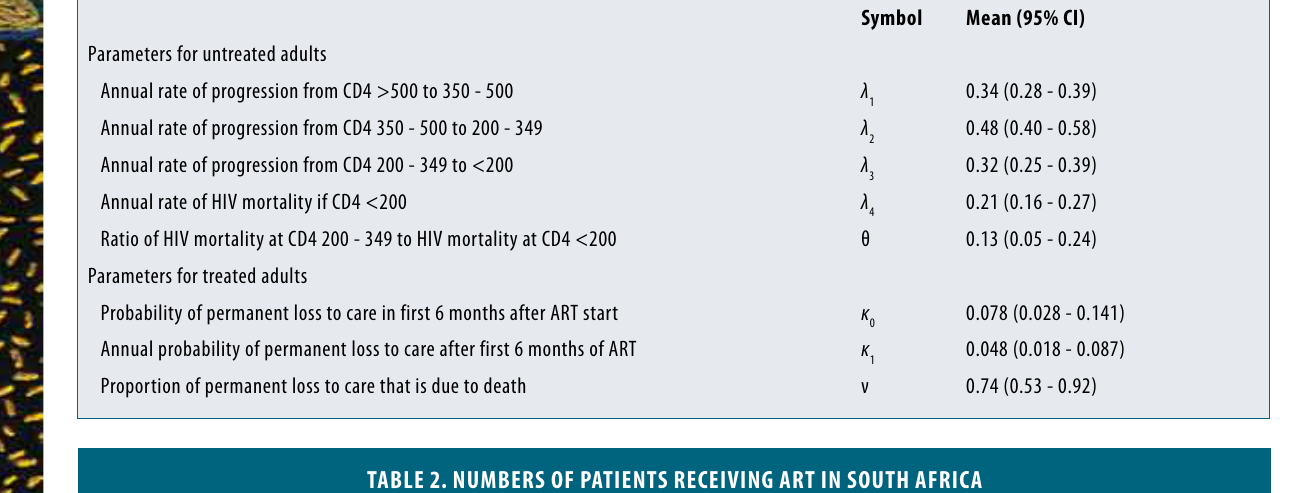
TABLE 1. pOsTERIOR EsTIMATEs OF MOdEL p